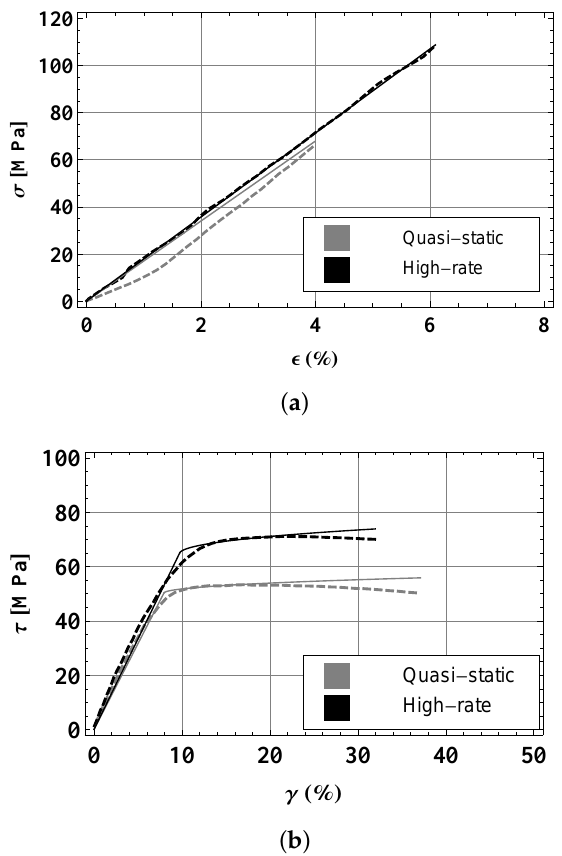
Figure 2. Stress–strain curves in pure loading conditions: ( a ) Stress–strain curves of the adhesive layer under a pure tensile load obtained with the proposed model for quasi-static and high-rate loading (solid lines) compared with experimental curves by [9] (dashed lines). ( b ) Stress–strain curves of the adhesive layer under a pure torsion load obtained with the proposed model for quasi-static and high-rate loading (solid lines) compared with experimental curves by [9] (dashed